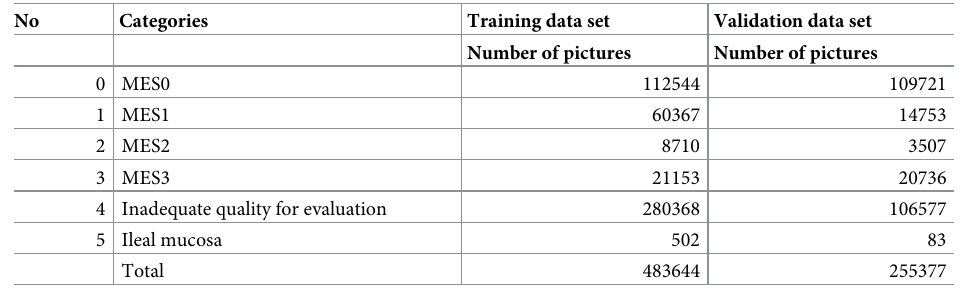
Table 2. Number of images in each training and validation